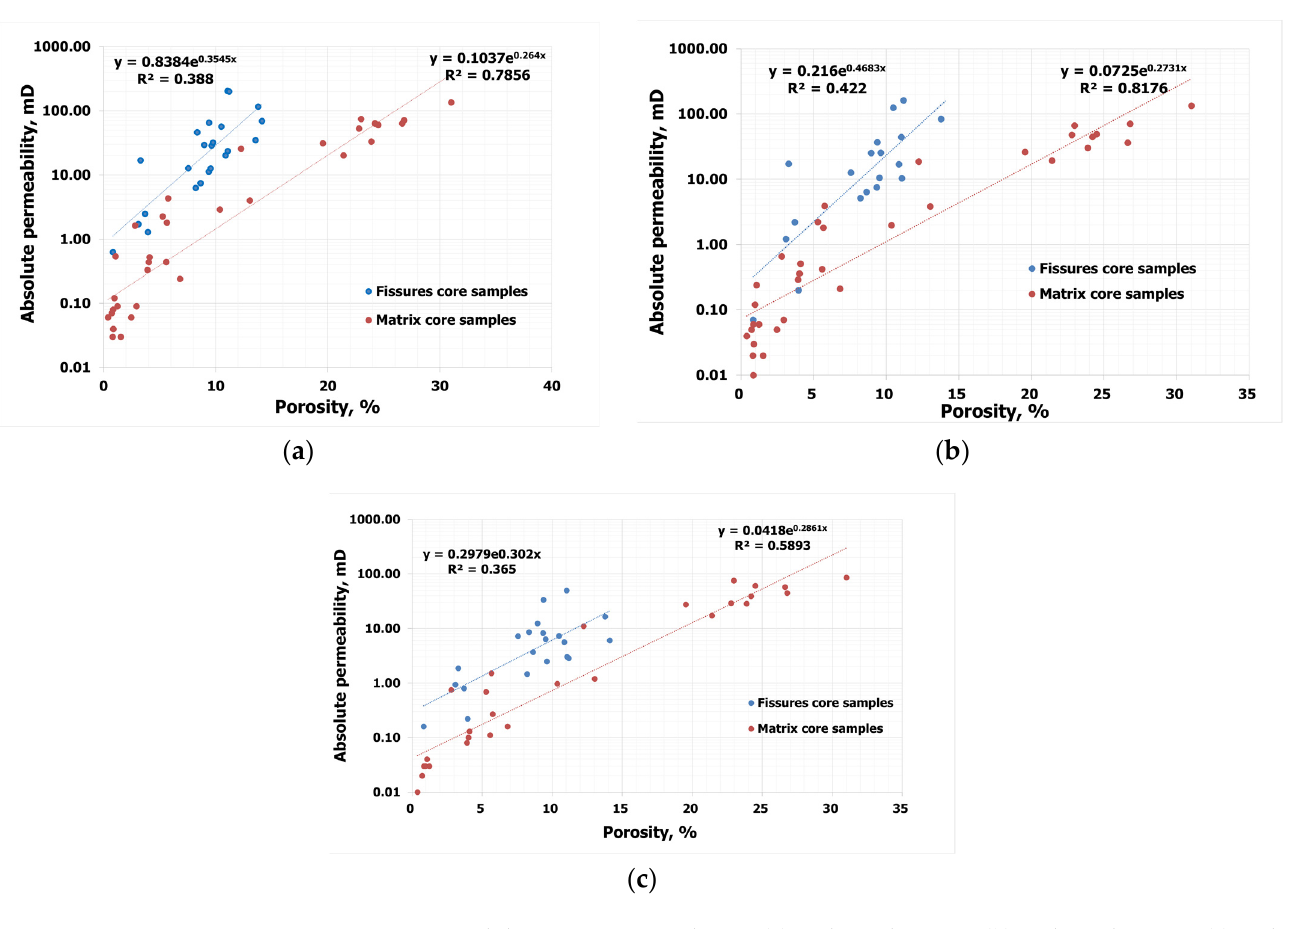
Figure 3. Permeability–porosity correlation: ( a ) in the X-direction, ( b ) in the Y-direction, ( c ) in the Z-direction.